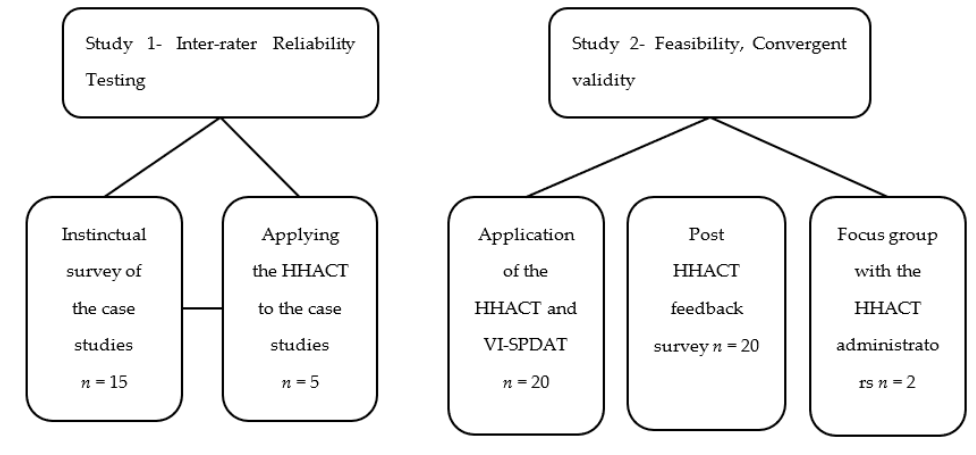
Figure 1. Study Flow